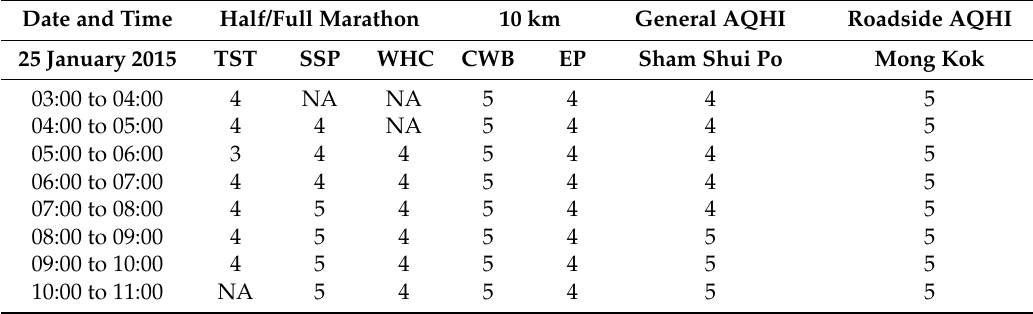
Table 4. AQHI-Green Marathon (GM) at the Marathon sensor network sites and at routine air monitoring stations. CWB, Causeway